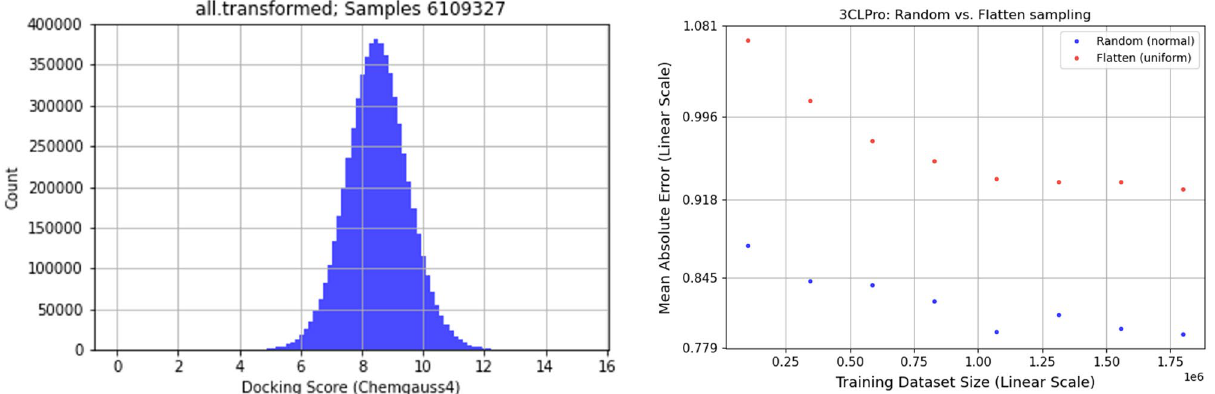
Figure 2. (left) Histogram of protein-ligand docking of transformed docking scores for 3CL-M pro . The distribution is from the ORZ dataset based on the transformed 2D scores. (right) Learning curve between dataset size and MAE between random and flattened datasets.